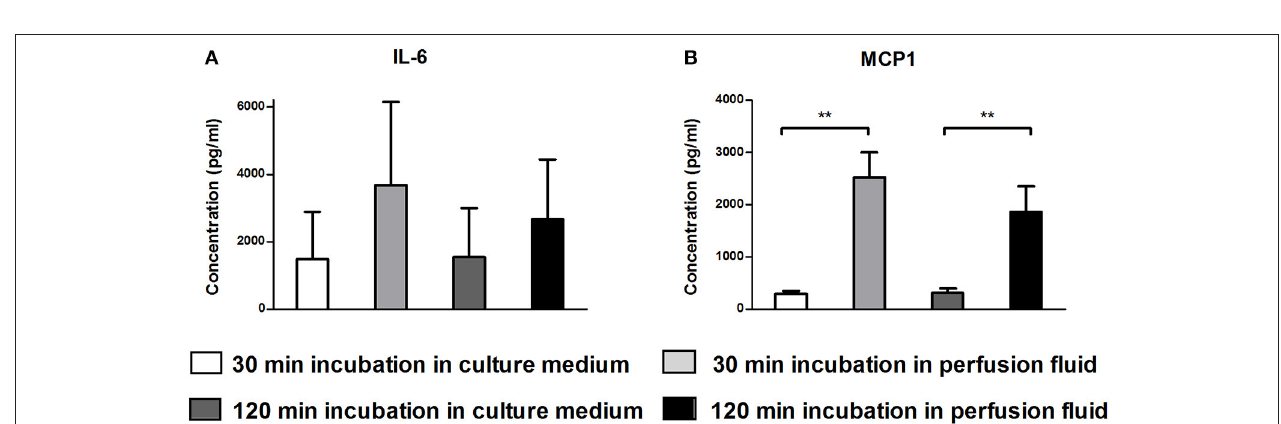
FIGURE 8 | Production of inflammatory cytokines by hMSC in culture medium and perfusion fluid. MSC were incubated in perfusion fluid for 30 or 120min, washed and replaced by culture medium for 24h. (A) The secretion of IL-6 shows tendency to increase by perfusion fluid. (B) The secretion of MCP-1 by MSC is increased after incubation in perfusion fluid ( n = 5). Results are shown as means ± SD. ** p <